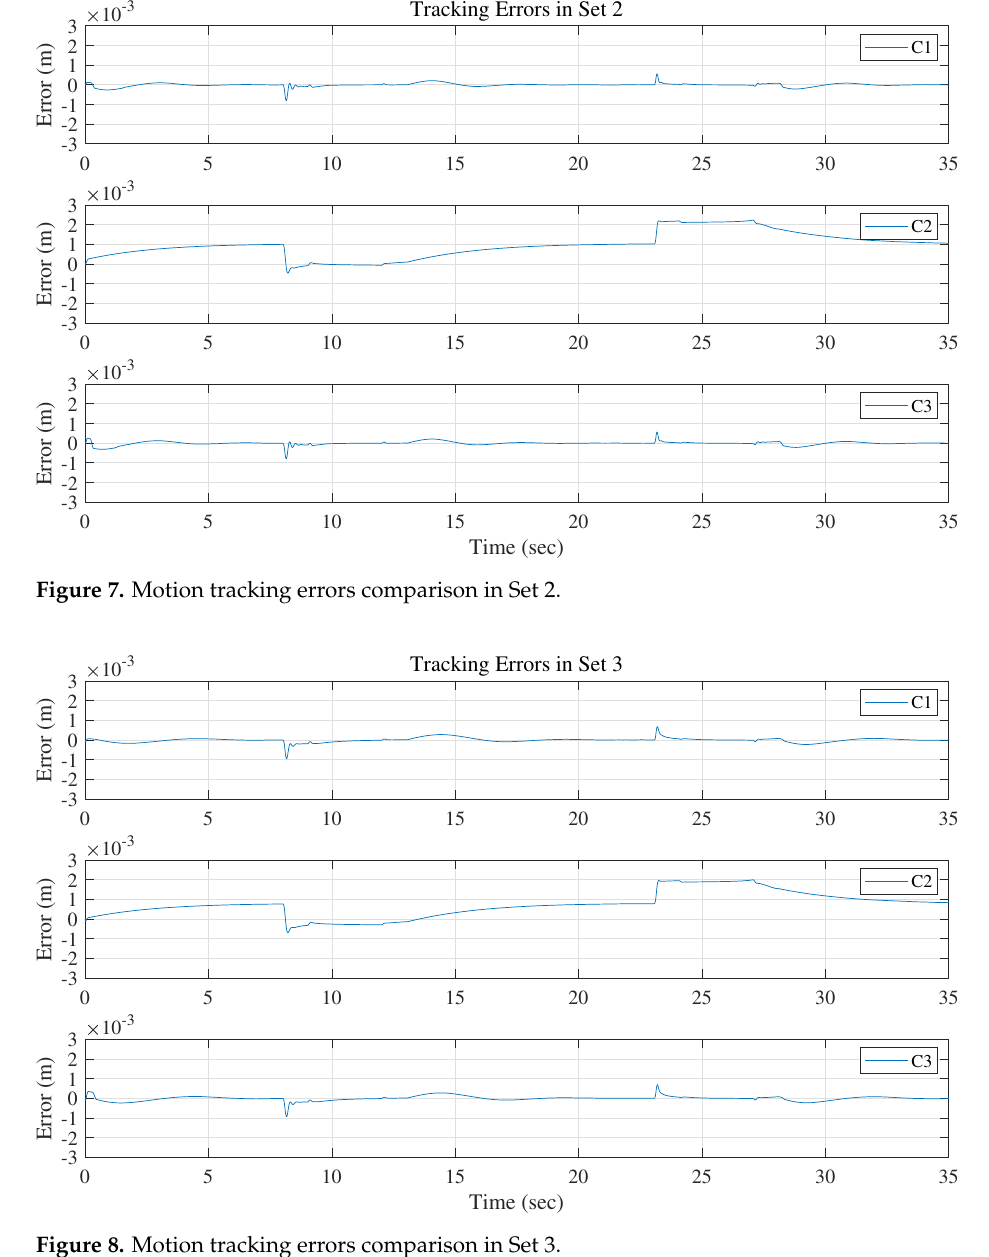
Figure 8. Motion tracking errors comparison in Set